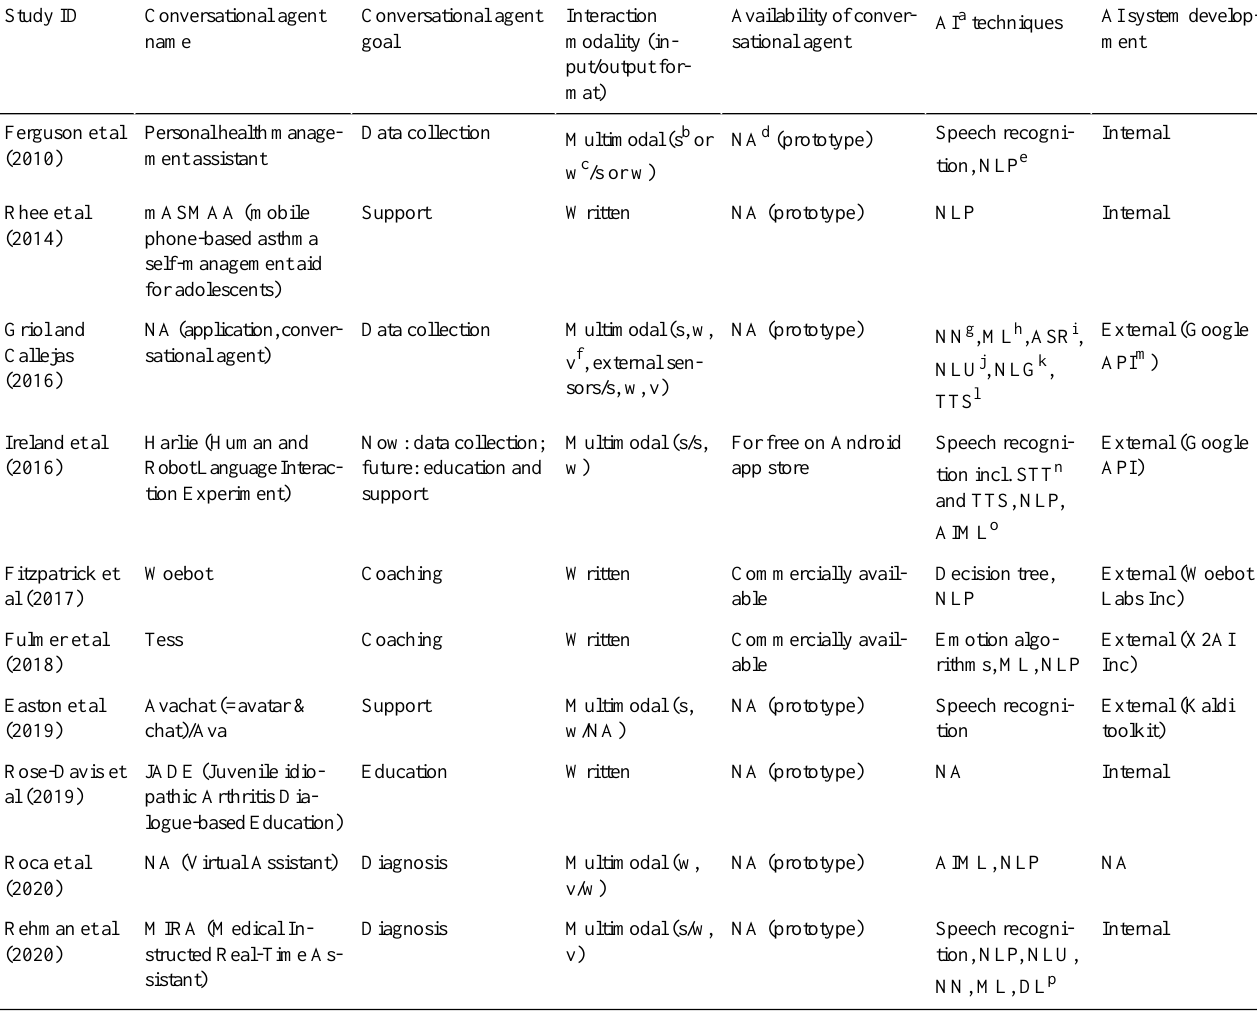
Table 3. Overview and characteristics of the conversational agents reported in the included